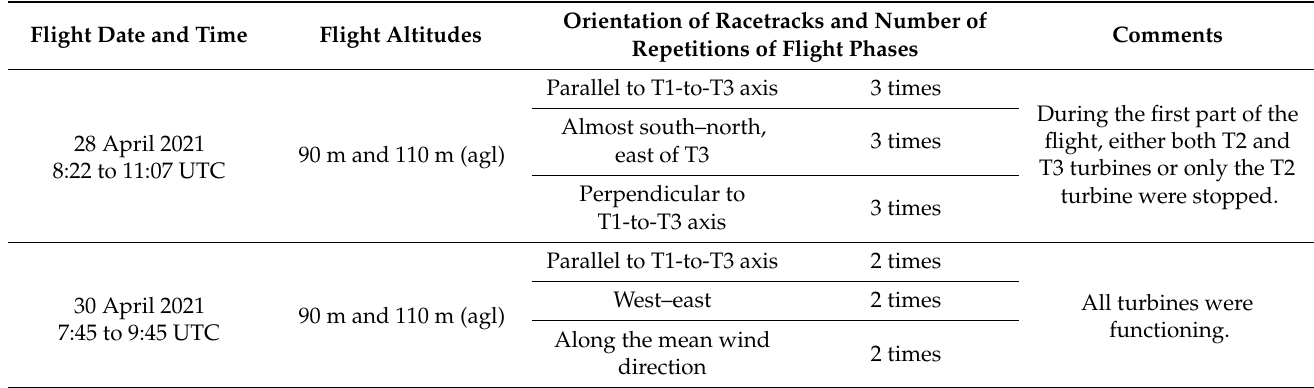
Table 1. Information about the date and trajectories of the two